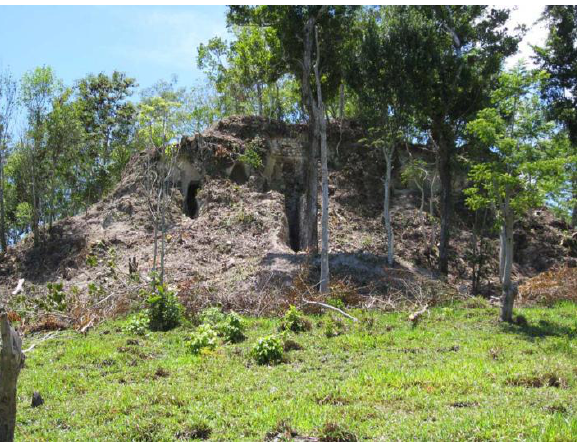
Figure 1. Archeological site of Chilonché in the region